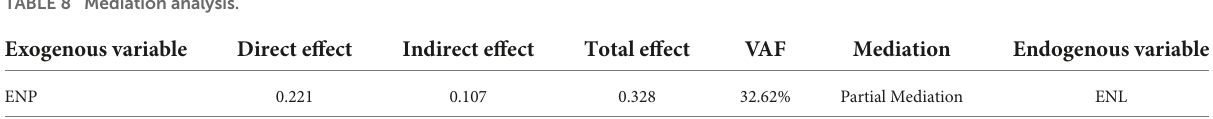
FIGURE3 Structural model.